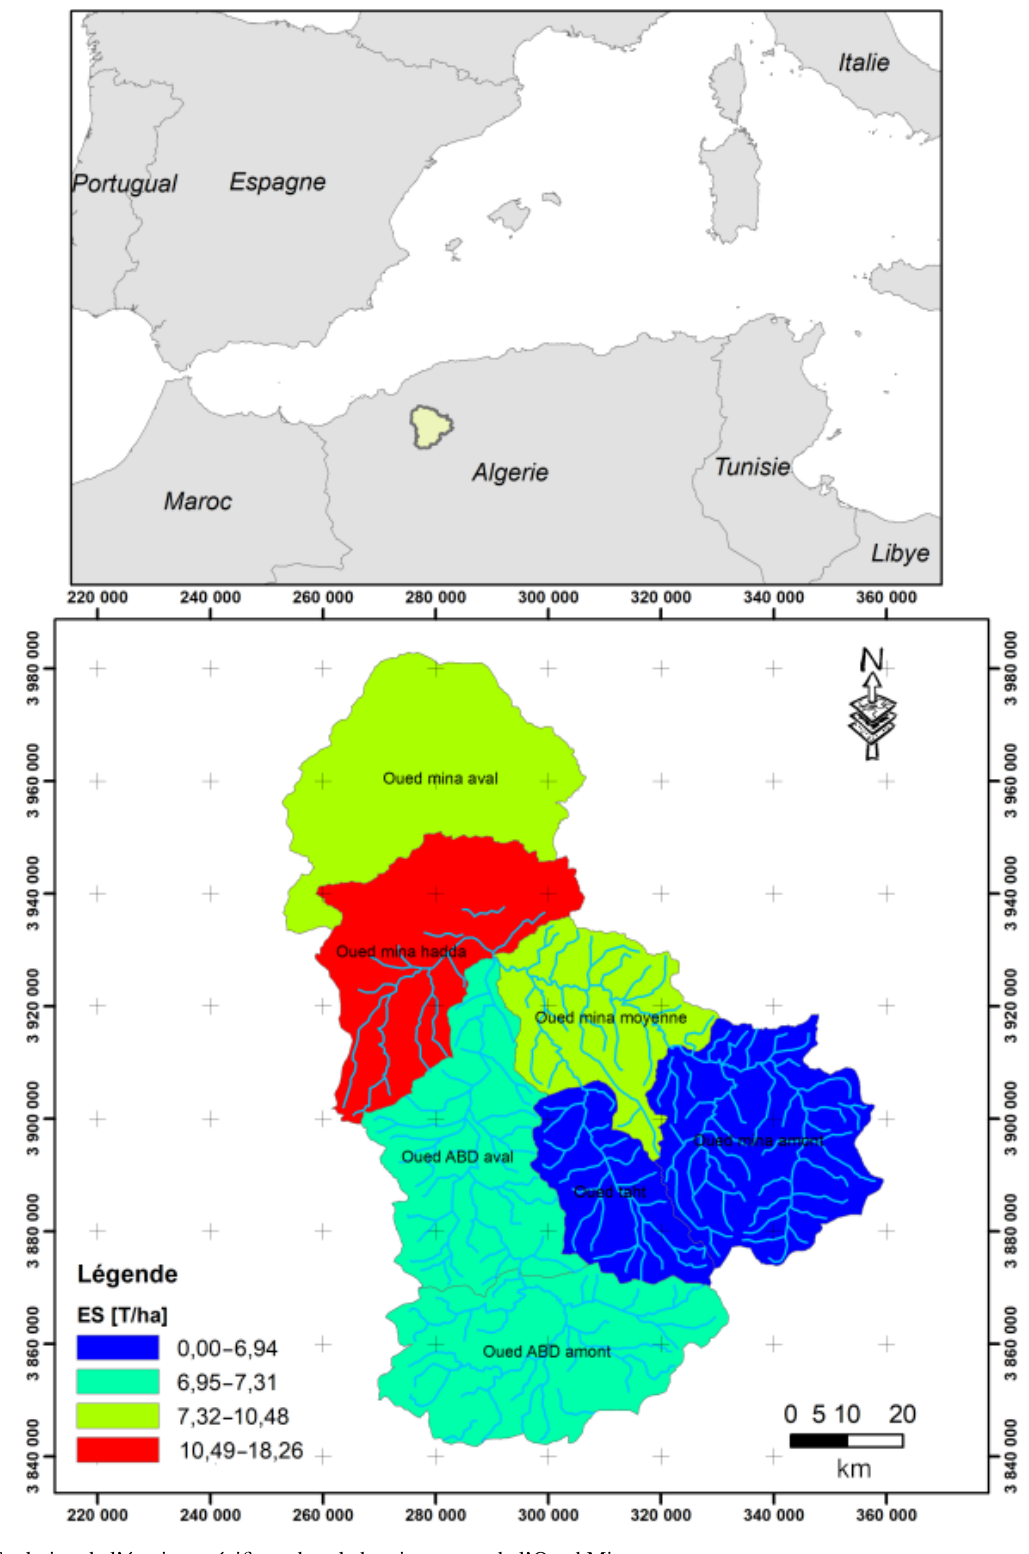
Proc. IAHS, 384, 155–161,